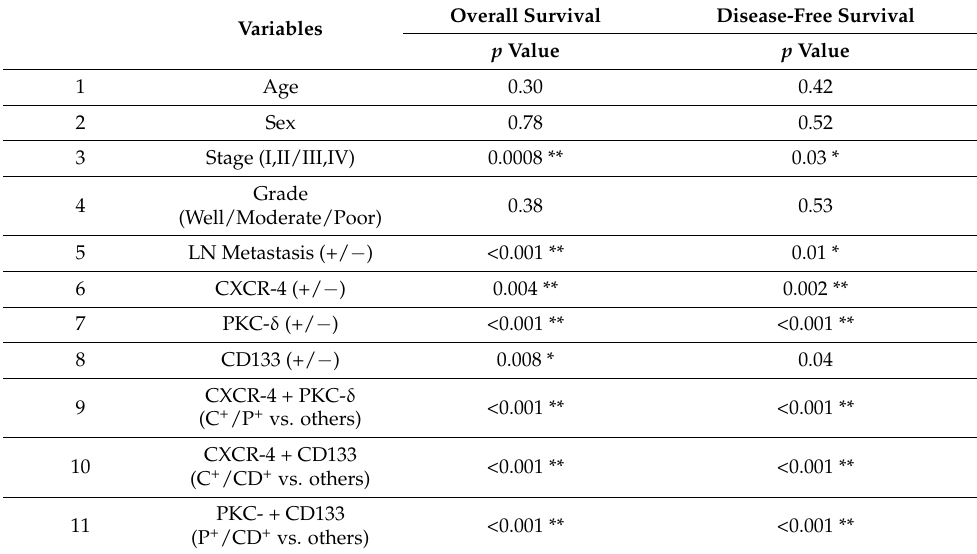
Figure 5. Disease-free survival of oral squamous cell carcinoma patients with CXCR-4 ( p = 0.002) ( a ), PKC- δ ( p = <0.001) ( b ), CD133 ( p = 0.04) ( c ), CXCR-4+PKC- δ (double positive; p = <0.001) ( d ) and CXCR-4 + CD133 (double positive; p = <0.001) ( e ) positivity analyzed by Kaplan–Meier method. Key: − = 0 and 1+ categories, + = 2+ and 3+ categories, LN = Lymph node, C+/P+ = CXCR-4 and PKC- δ double positive cases, C+/CD+ = CXCR-4 and CD133 double positive cases. Table 4. Survival analysis of clinicopathological variables, CXCR-4, PKC- δ and